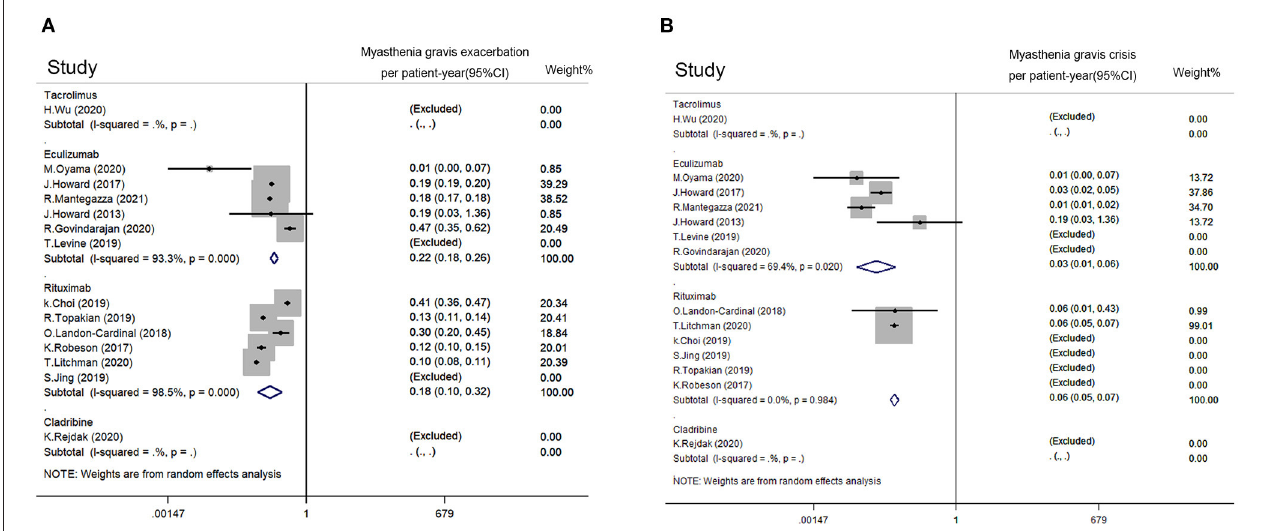
FIGURE 4 | Impact from immunotherapies on refractory MG based on disease exacerbation. (A) MG exacerbation rate per patient-year of rituximab, eculizumab, tacrolimus, and cladribine. (B) MG crisis rate per patient-year of rituximab, eculizumab, tacrolimus, and cladribine. MG exacerbation was defined as MG symptoms with increased frequency and/or intensity. Myasthenic crisis was defined as exacerbated MG symptoms that required intubation or rescue therapy such as plasma exchange and intravenous immunoglobulin. A random-effect model was used for quantitative synthesis. No significant difference in frequency of MG exacerbation or crisis between the rituximab group and eculizumab group was revealed. The studies with Tacrolimus and cladribine were excluded since no disease exacerbation or crisis has been